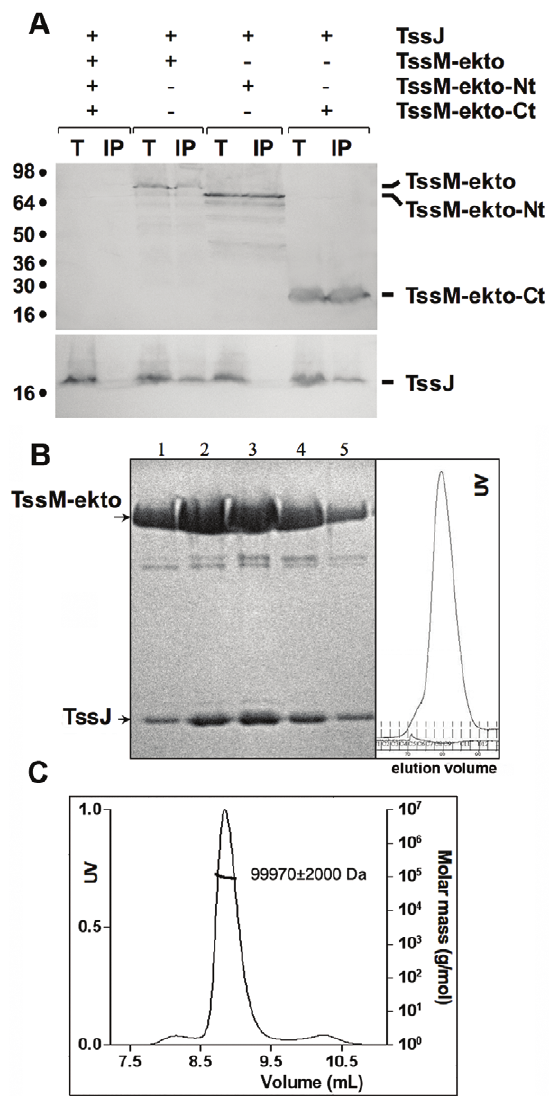
Figure 2. TssJ interacts with the C-terminal domain of TssM. ( A ) Solubilized extracts of E. coli K12 W3110 strain producing ( + ) or not (-) HA-tagged TssJ and FLAG-tagged TssM-ekto or -Nt or –Ct derivatives were subjected to immunoprecipitation with anti-FLAG-coupled beads. The total solubilized material (T) and the immunoprecipitated material (IP) were loaded on a 12.5%-acrylamide SDS PAGE, and immunode- tected with anti-HA (TssJ; lower panel) and anti-FLAG (TssM-ekto and sub-domains; upper panel) monoclonal antibodies. Immunodetected proteins are indicated on the right. Molecular weight markers are indicated on the left. ( B ) Gel filtration showing the direct interaction of TssM-ekto with TssJ. The SDS-PAGE analysis of the fractions is shown on the left panel. The chromatogram of the gel filtration is shown on the right panel. ( C ) MALS/QELS/UV/RI analysis of the TssM-ekto/TssJ